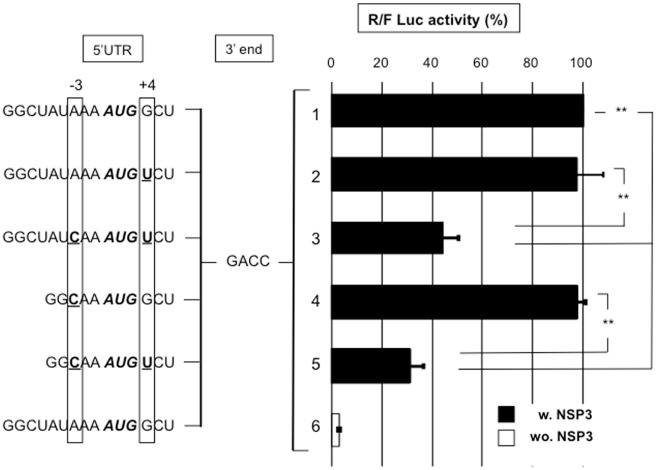
The importance of the initiation codon context in NSP3-dependent translation.BSRT7 cells expressing NSP3 (black bars) or no NSP3 (NSP3-KO) (wo. NSP3 white bar) were electroporated with the standard RNA and with capped R-RNA (lines 1–6) with 9- (lines 1–3,6) or 5- (lines 4,5) nt-long 5’UTRs with different AUG (bold and italicized) contexts. The -3 and +4 positions are boxed, and the nucleotides that differ from the wild type (line1) are underlined. The Renilla and firefly luciferase activities were measured 6 hours after electroporation. The ratio of Renilla to firefly luciferase activities is reported relative to the control (line 1), which was considered 100. The data are the mean ± SEM of three independent experiments in triplicate. A Student’s t-test was used (*p<0.05;**p<0,01).